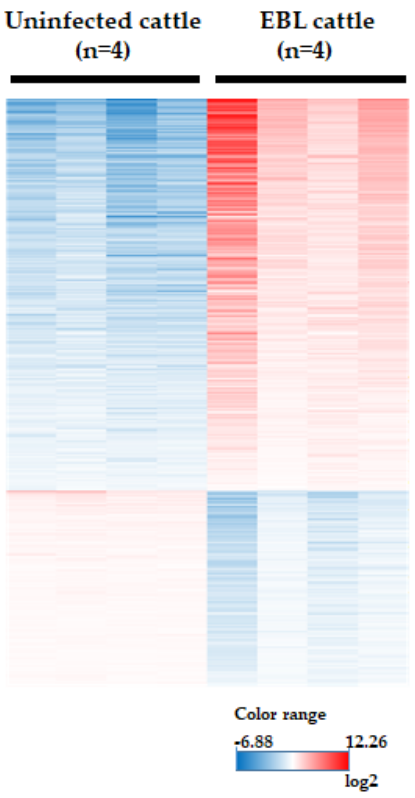
Figure 2. Heatmap of microarray analysis. The microarray data were analyzed using GeneSpring GX software. Color-coded scale bar represents relative signal intensities of the quantities of mRNA in each group.